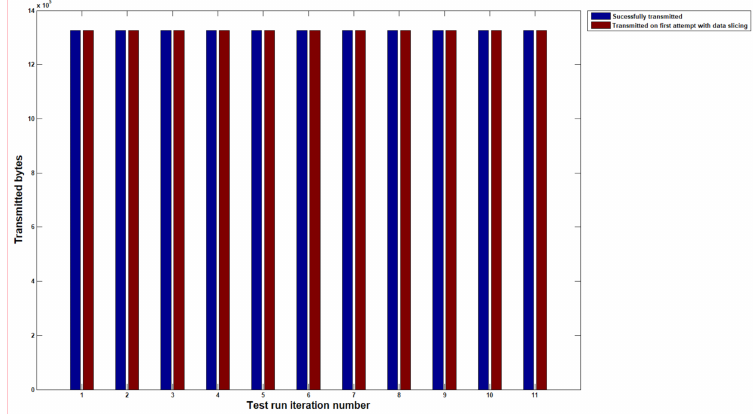
Figure 5. Initial results on daily load profile reading over PLC-PRIME from PLC-A to PLC-C.